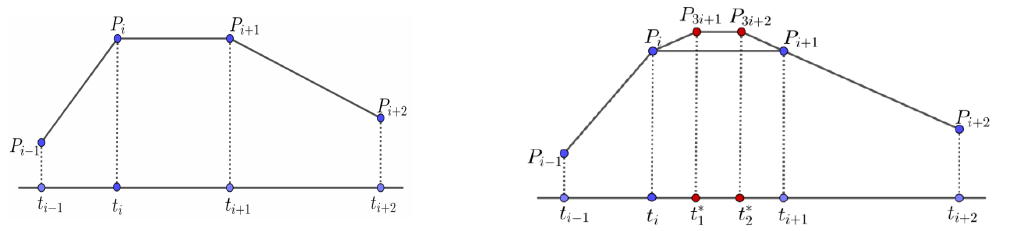
Figure 1. Parameterization of the data points. Left: t i + k is the parameter of the initial control point, P i + k , k = − 1,0,1,2. Right: t ∗ , t ∗ are the parameters of the new control points, P 3 i + 1 and P 3 i + 2 , respectively.